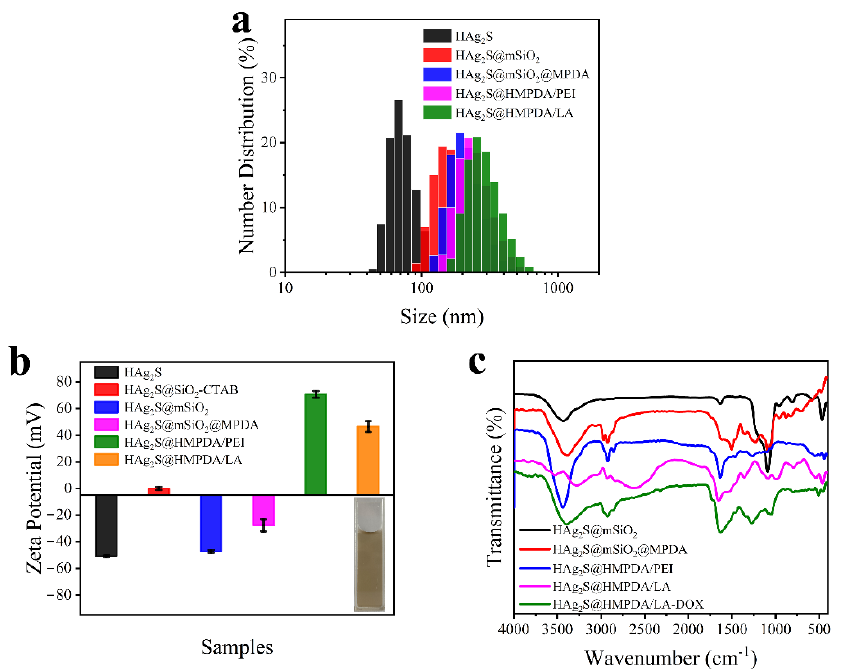
Figure 6. Particle size distributions measured by DLS ( a ); zeta potentials ( b ), with an inserted photo showing the colloidal stability of HAg 2 S@HMPDA/LA aqueous solutions; and FTIR spectra ( c ) of different samples.